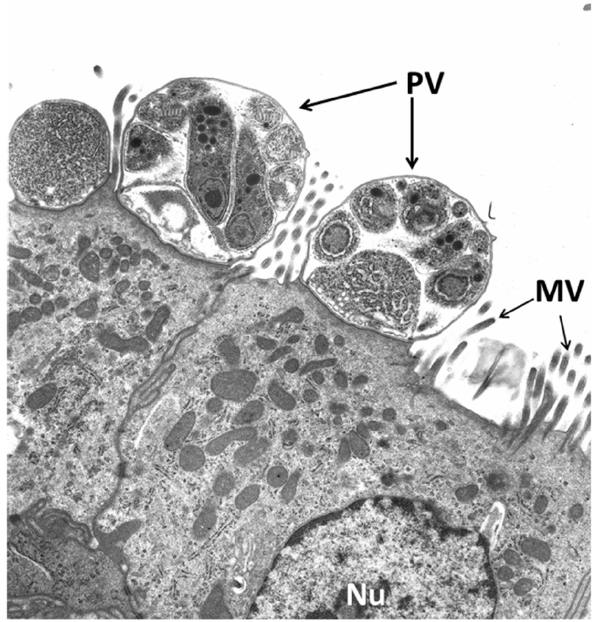
Figure 2. Cryptosporidiosis in an SIV-infected rhesus macaque. Enterocytes (Nu – nucleus) with adjacent parasites. The par- asitophorous vacuoles (PV) are probably formed by the mi- crovilli (MV) of the affected enterocytes. The ultrastructure of the vacuoles argue for the morphology of schizonts containing mero- zoites. Cryptosporidiosis is a typical opportunistic infection in SIV- infected macaques. Transmission electron